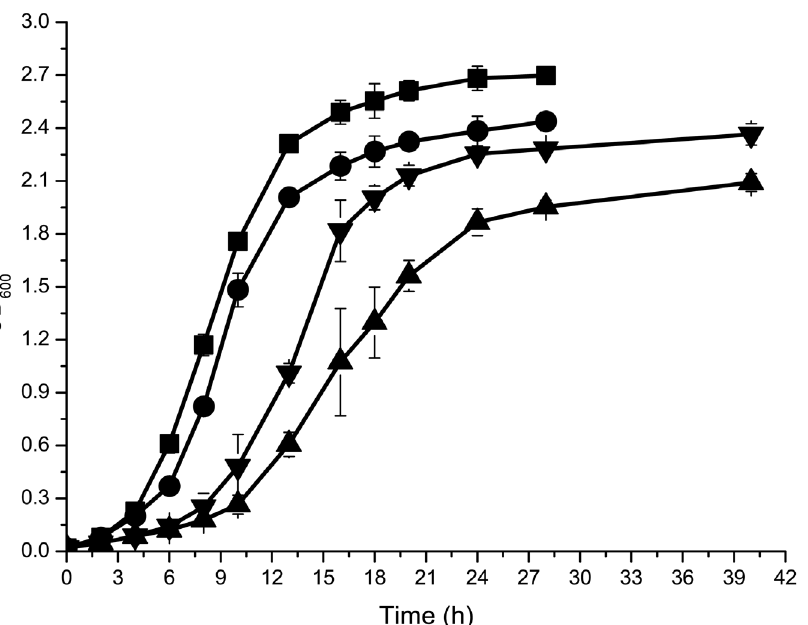
N Figure 1. Growth curves of WT WP3 and the fur mutant in liquid 2216E with or without 60 m M iron chelator under aerobic ) fur mutant, ( m ) WT WP3 with 60 m M iron chelator, and ( . ) fur mutant with 60 m M iron chelator. The data represent conditions. ( & ) WT WP3, ( averages of triplicate cultures.